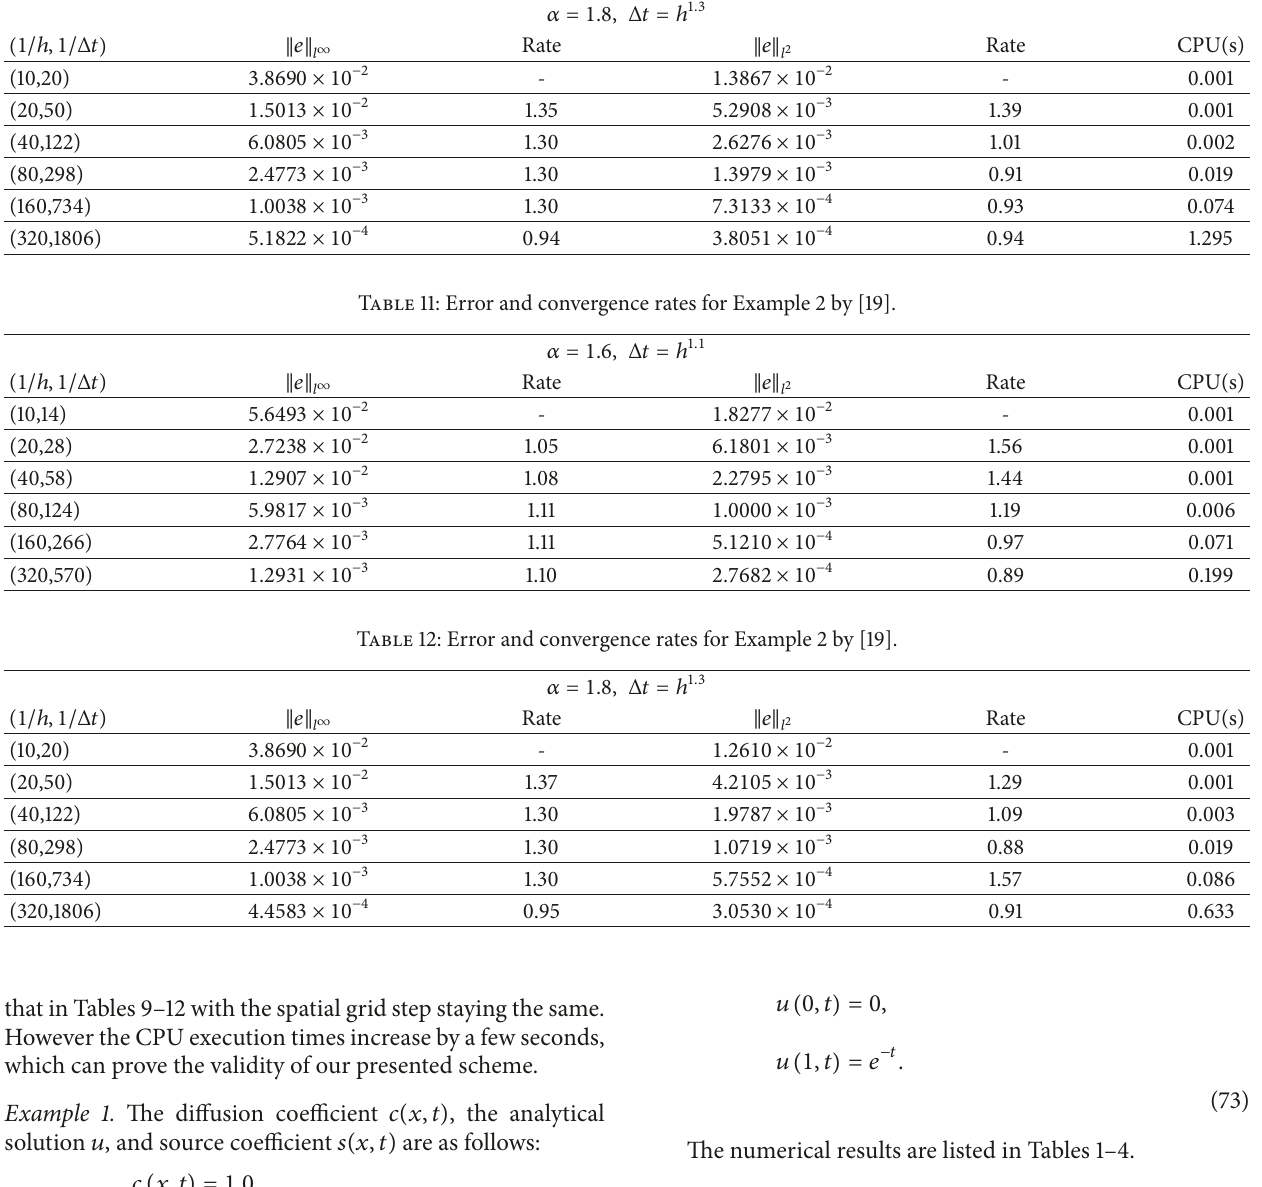
Table 10: Error and convergence rates for Example 1 by [19].